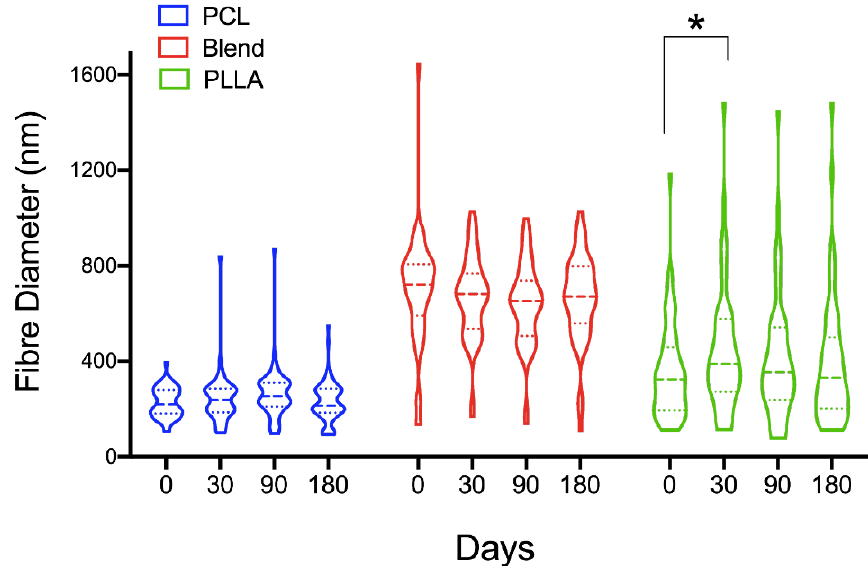
Figure 2. Changes in fiber diameter with time for 50:50 PCL:PLLA blend, PCL and PLLA scaffolds. Statistical comparison performed with two-way ANOVA and Dunnett’s multiple comparisons test (* p < 0.05; n = 50).